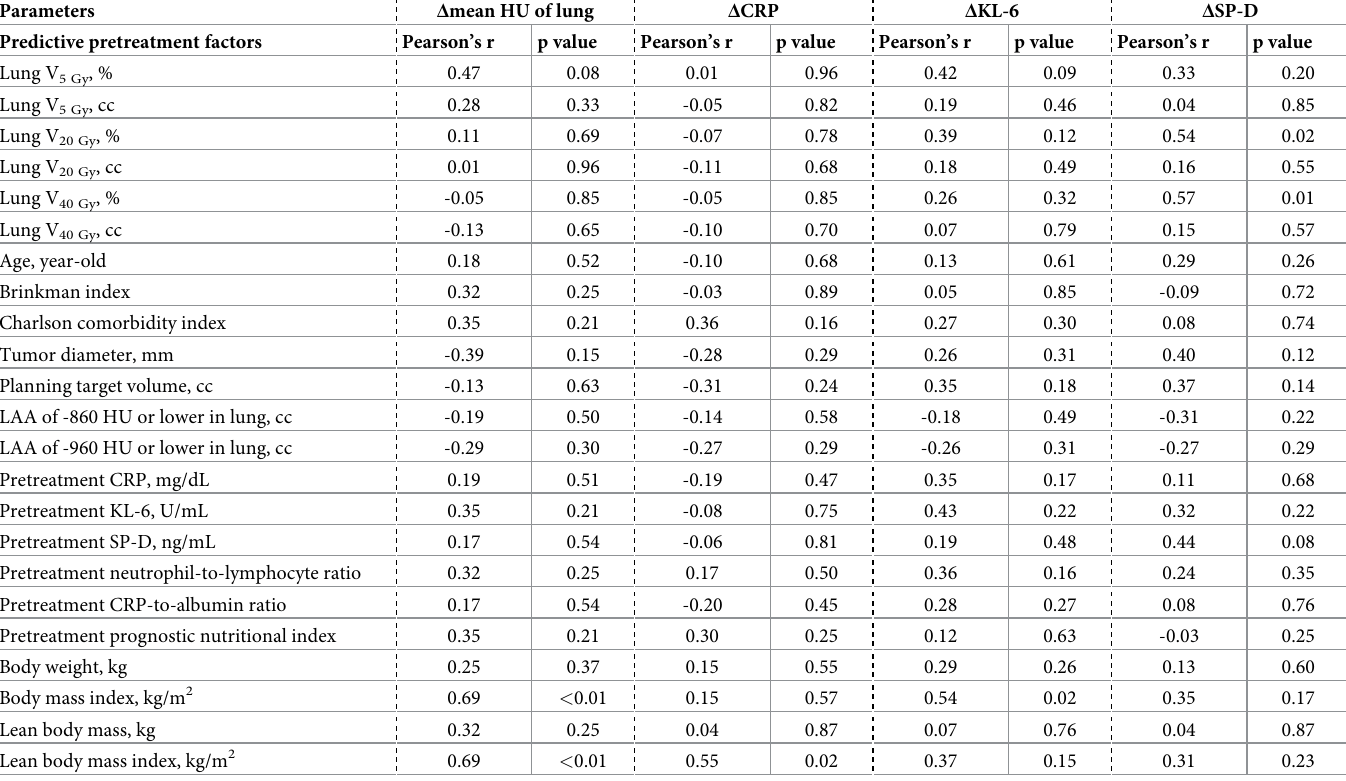
Table 3. Predictive factors for changes in parameters from baseline to 4 months after